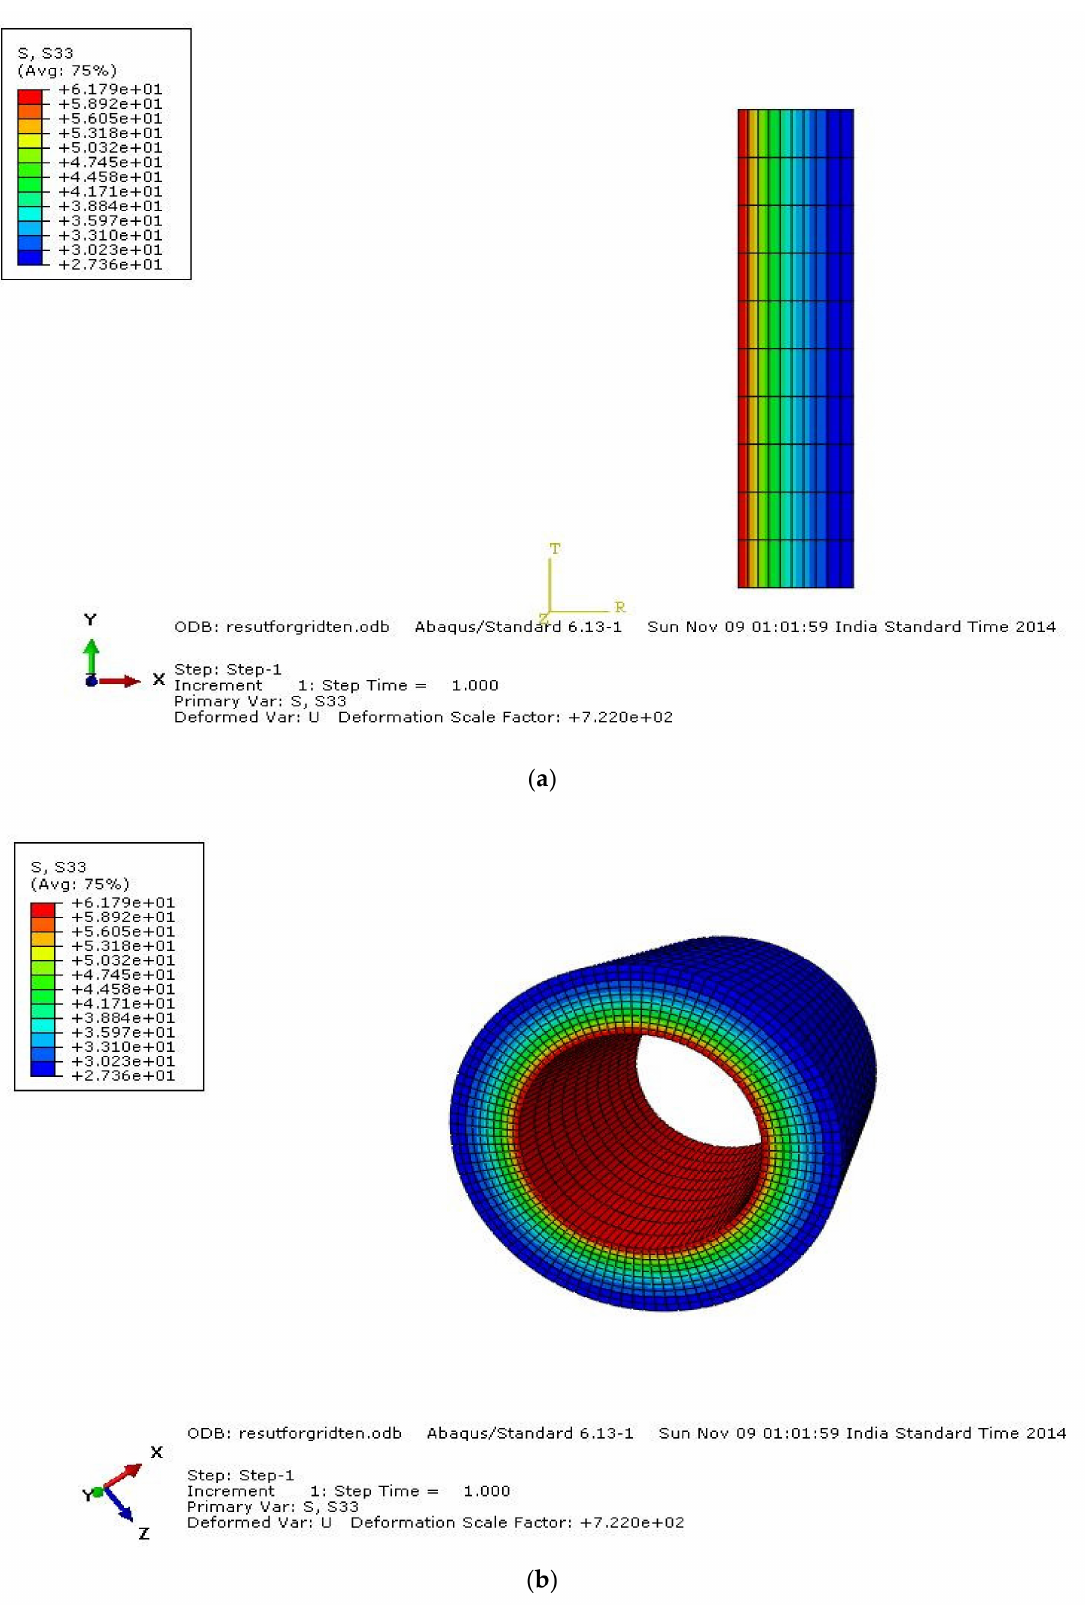
Figure 7. Analysis on sweep of circumferential stress elements: ( a ) before, ( b )